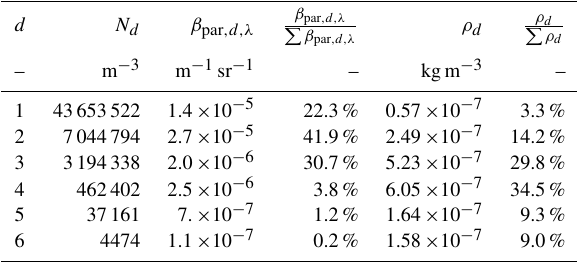
Table 4. Point-data extraction of COMSO-ART output at the Deuselbach ACL station; coordinate 1 is on 16 April 2010, 18:00UTC, at a height of 1.9kma.s.l. The individual backscatter coefficient β par ,d,λ , the contribution to the total backscatter coeffi- cient P β par ,d,λ , the individual mass density ρ d , and the contribu- tion to the total mass density P ρ d were calculated based on the model-predicted particle number density N d of each size class d at this coordinate. Ash particles were calculated using a volumetric mass density of 2500kgm − 3 . A non-linear relationship between the relative contribution to the total backscatter coefficient and the relative contribution to the transported mass of an ash size class can be observed: while the first three classes contribute 95% of the to- tal backscatter coefficient, they carry only 78% of the volcanic ash mass. This dependency on the laser wavelength can be seen as an advantage for multi-wavelength lidar systems.